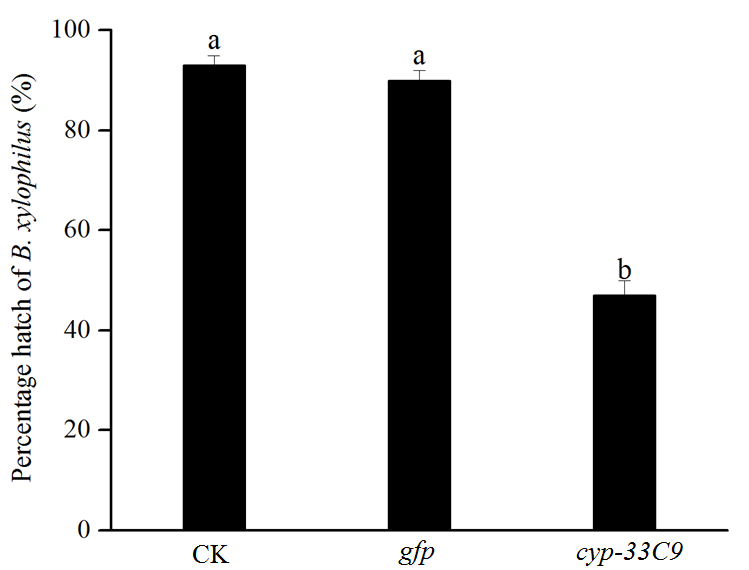
Figure 3. The percentage hatch of Bursaphelenchus xylophilus after RNA interference of cyp-33C9 . The bars indicate the standard deviation, and different letters indicate significant differences ( p < 0.05), according to Tukey’s test, among the treat ments.